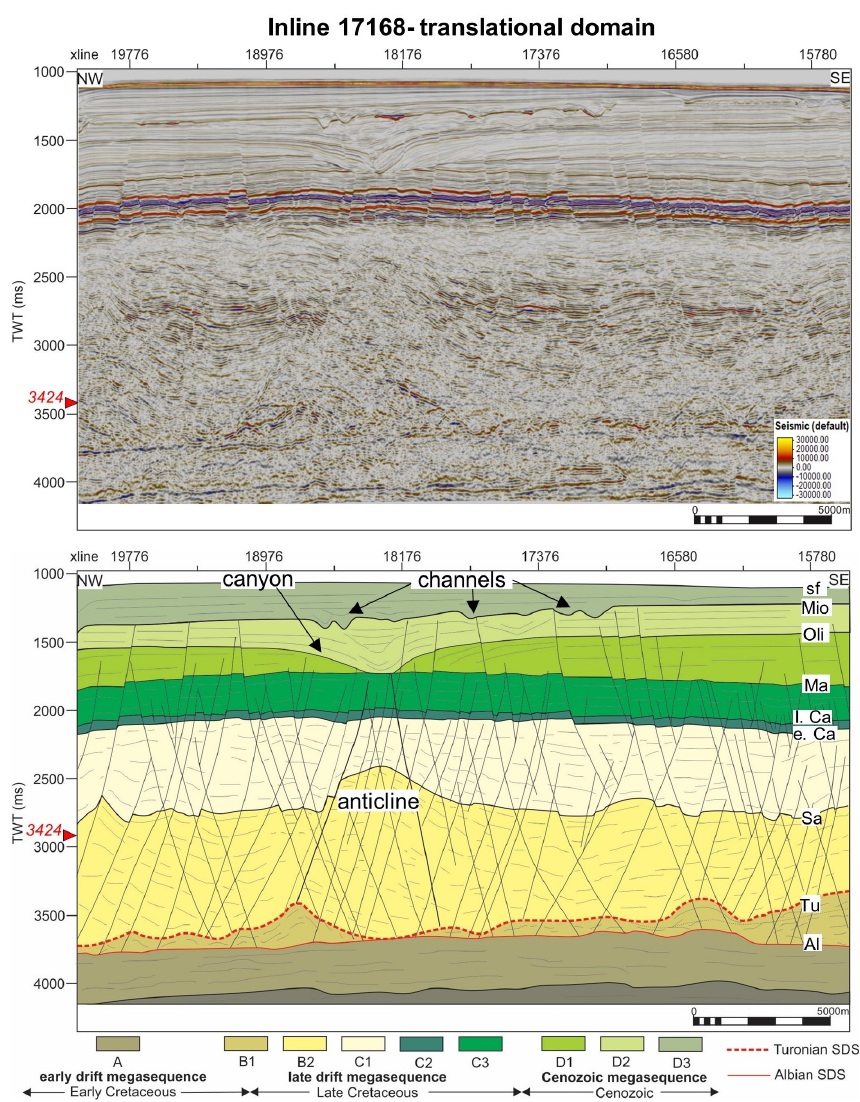
Figure 8. Uninterpreted and interpreted sections of inline 17168 showing the translational domain and position of time slice 3424. Normal faults extend to the Albian surface at depth and upwards into the Cenozoic megasequence with some terminating at Oligocene or Miocene unconformity